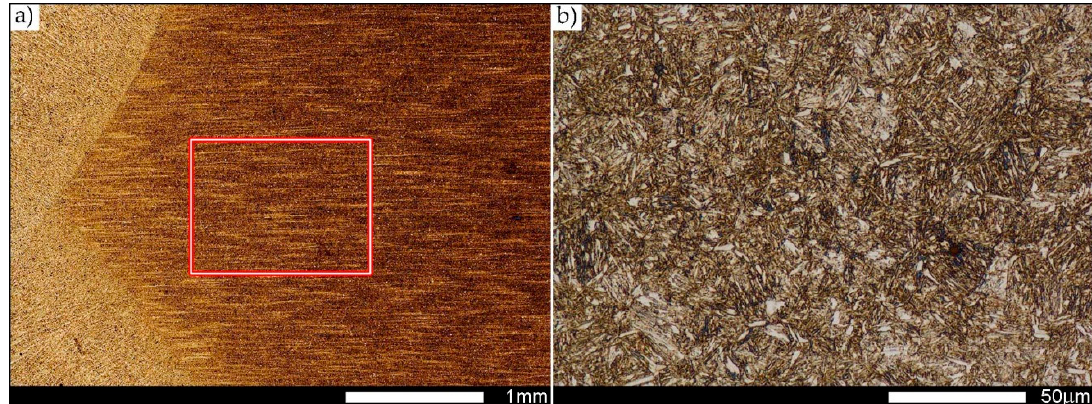
Figure 23. Microstructure of Hardox Extreme welded joint after heat treatment: ( a ) in the area marked HAZ in Figure 6; ( b ) an enlarged image marked with frame in Figure 23a. Structure of fine-lath hardening martensite. Light microscopy, etched with 2% HNO 3 .